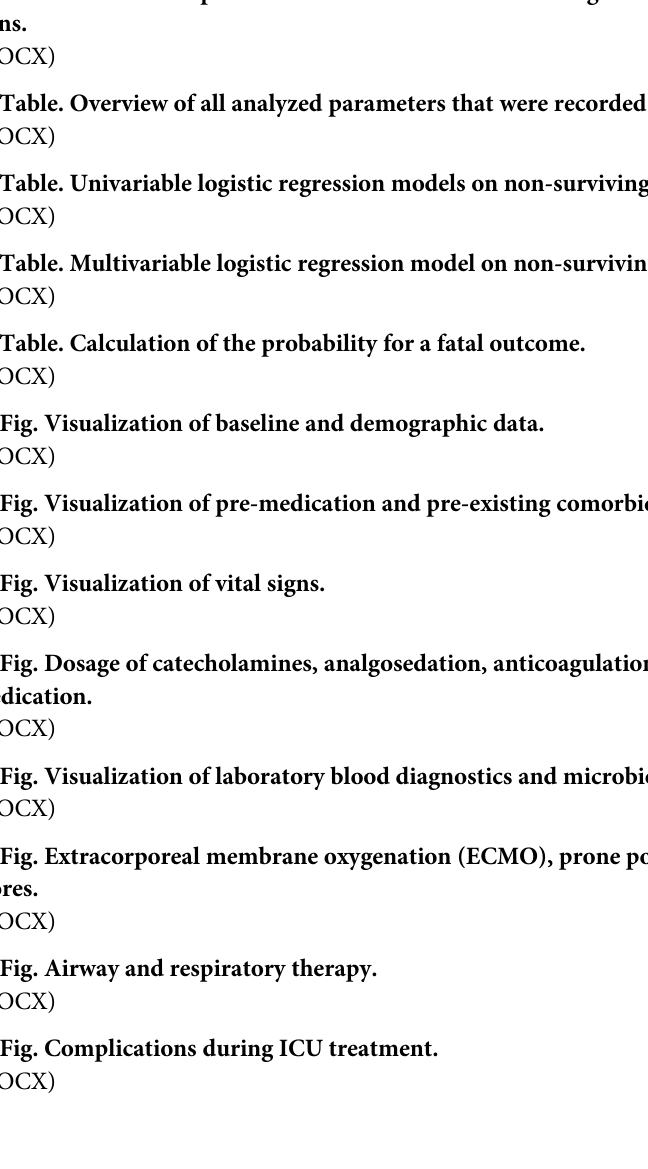
S8 Fig. Complications during ICU